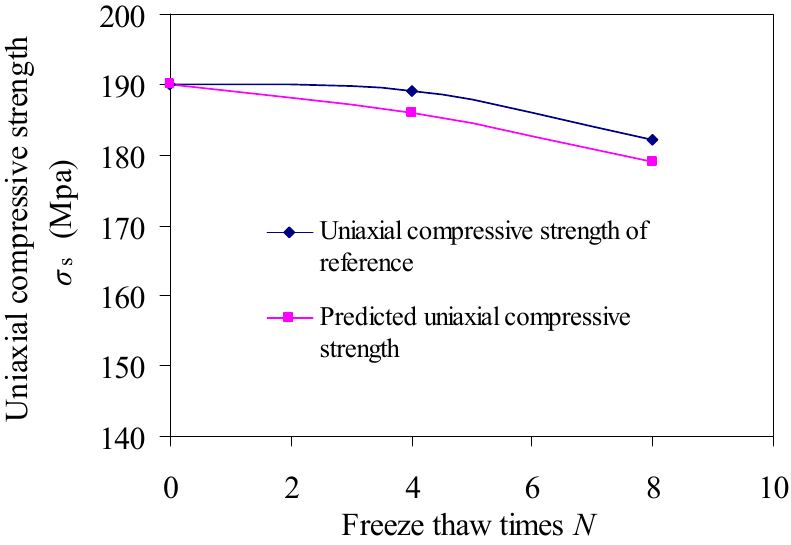
Figure 13. Uniaxial compressive strength of limestone.